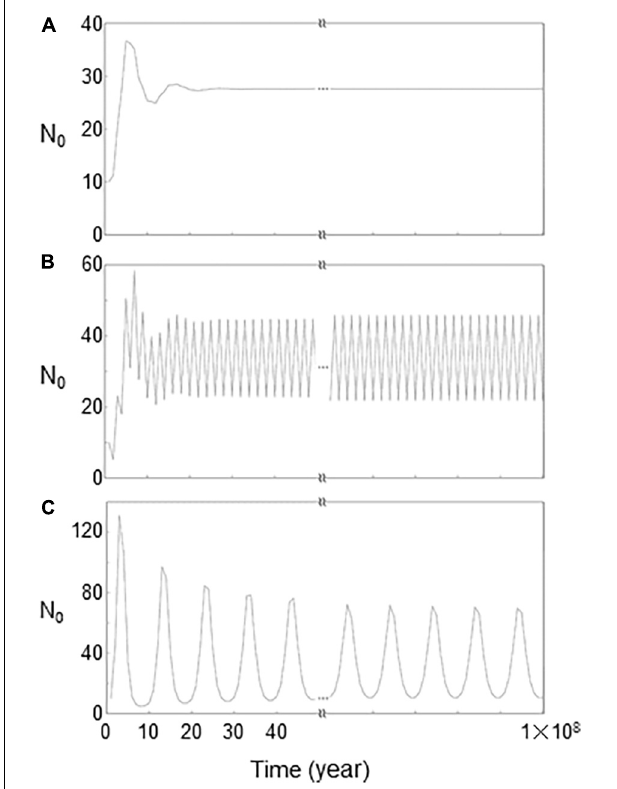
FIGURE 2 | Example of the three types of final states in the Moso bamboo age-structured model. (A) Stable type with the parameter sets P new _N 0 = 1.2, P new = 1.2, P old = 0.4, (B) 2-year cycle type with the parameter set P new _N 0 = 0.5, P new = 2.5, P old = 0.2, and (C) more than 2-year cycle with the parameter set P new _N 0 = 5.0, P new = 0.2, and P old = 0.2. Note that P new _N 0 , P new , and P old represent photosynthesis rates of zero-year-old culms’ leaves, new leaves, and old leaves,